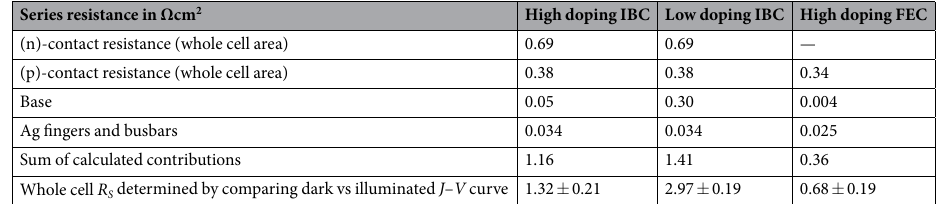
Table 3. Series resistance contributions to various cells and the series resistance determined by comparing dark and illuminated J – V